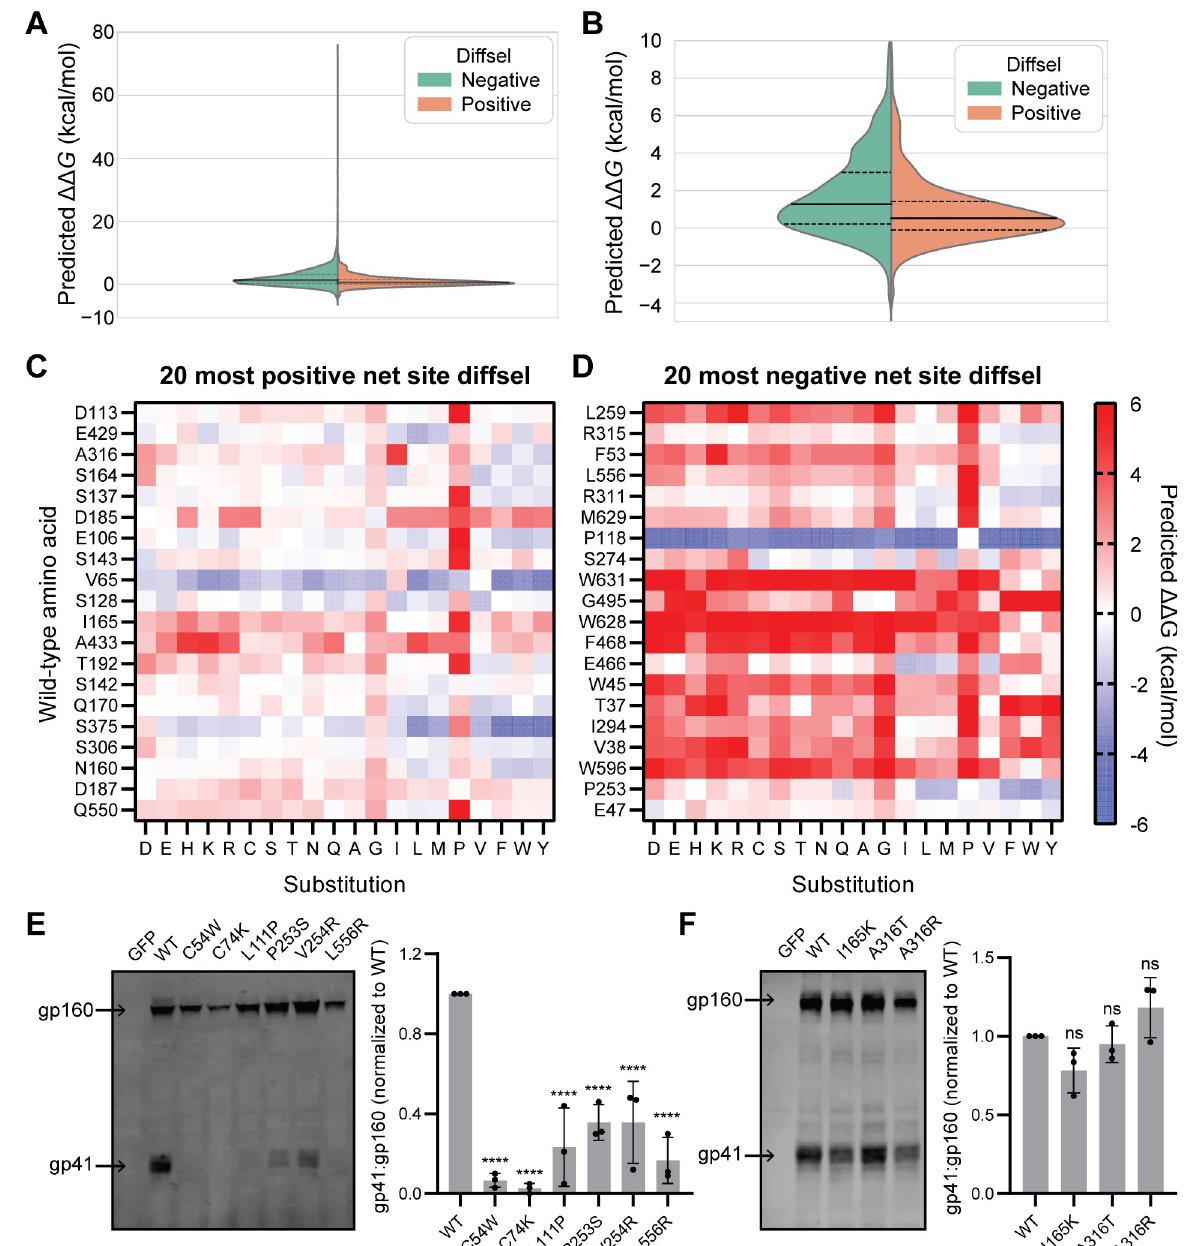
Fig 3. Env variants displaying negative differential selection (diffsel) upon XBP1s induction tend to be more destabilizing and exhibit greater processing defects than those displaying positive diffsel. (A) Split violin plot depicting the distribution of ΔΔ G values predicted using the Rosetta ΔΔ G protocol, for all amino acid substitutions that were present in the filtered deep mutational scanning dataset for +XBP1s versus basal (2,379 negative diffsel variants; 756 positive diffsel variants). Dashed lines inside the violins indicate the first and third quartiles, and the solid line inside the violins indicates the median. (B) Zoom-in of the violin plot in (A) focusing on ΔΔ G < 10 kcal/mol. (C and D) Heatmaps showing the predicted ΔΔ G values for all possible amino acid substitutions at the 20 sites with the most positive net site diffsel (C) and the 20 sites with the most negative net site diffsel (D), upon XBP1s induction. Substitutions ( x -axis) are arranged by side-chain properties: negatively charged (D, E), positively charged (H, K, R), polar uncharged (C, S, T, N, Q), small nonpolar (A, G), aliphatic (I, L, M, P, V), and aromatic (F, W, Y). Wild-type (WT) amino acids ( y -axis) are arranged by rank order of net site diffsel, with (C) D113 most positive and (D) L259 most negative. Complete ΔΔ G values are provided in S5 Data. (E) Representative immunoblot showing gp160 and gp41 bands for selected variants with negative diffsel upon XBP1s induction (left) and densitometric analysis of gp41:gp160 ratio across biological triplicates (right). (F) Representative immunoblot showing gp160 and gp41 bands for selected variants with positive diffsel upon XBP1s induction (left) and densitometric analysis of the gp41:gp160 ratio across biological triplicates (right). For (E) and (F), statistical significance was calculated by 1-way ANOVA followed